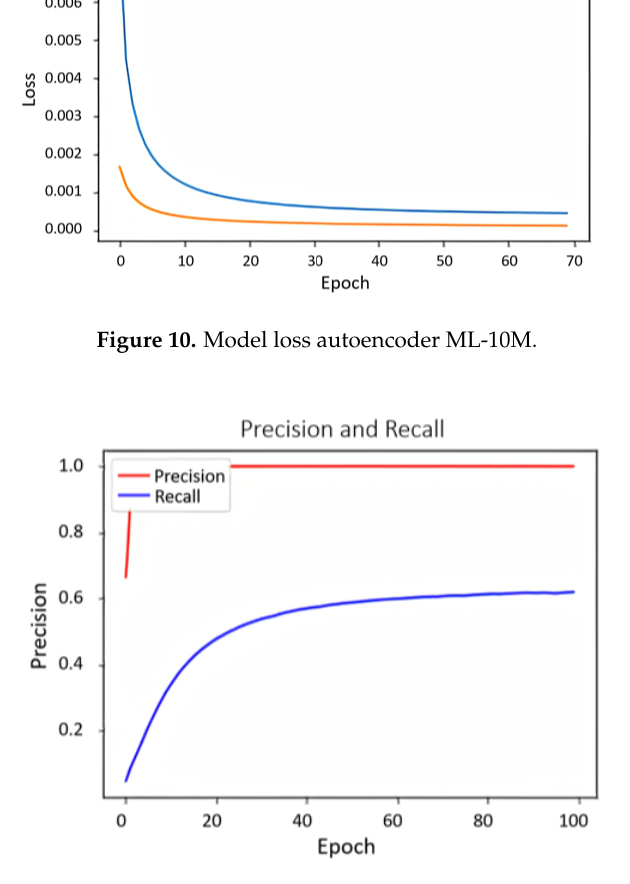
Figure 11. Precision and Recall of